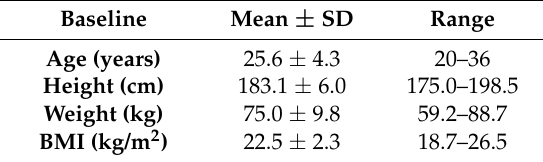
Table 3. Baseline characteristics